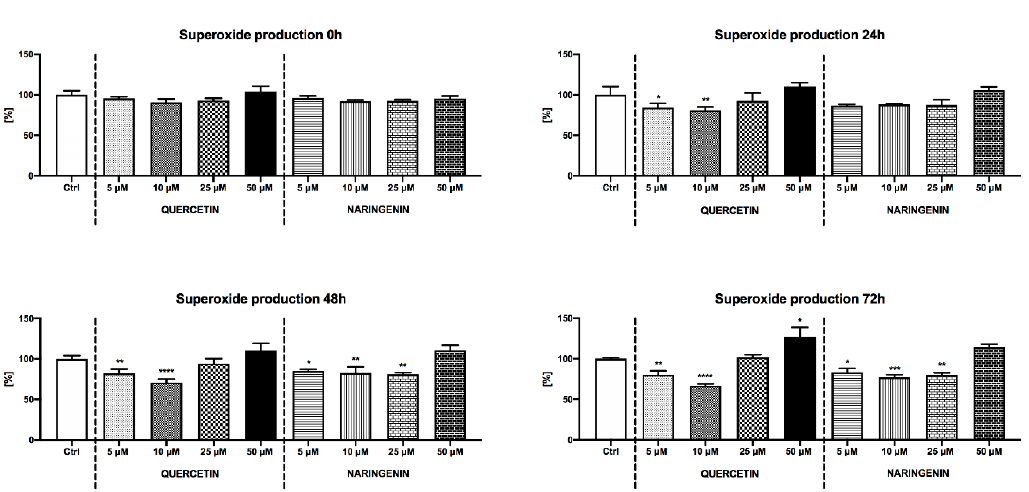
Figure 2. Intracellular superoxide production of boar spermatozoa extended in the presence of quercetin or naringenin. Each bar represents mean ( ± S.D.) optical density as the percentage of the control, which was set to 100% and the data are expressed as a% of the control value. The data were obtained from four independent experiments. Mean ± S.D. * p < 0.05; ** p < 0.01; *** p < 0.001; **** p < 0.0001.